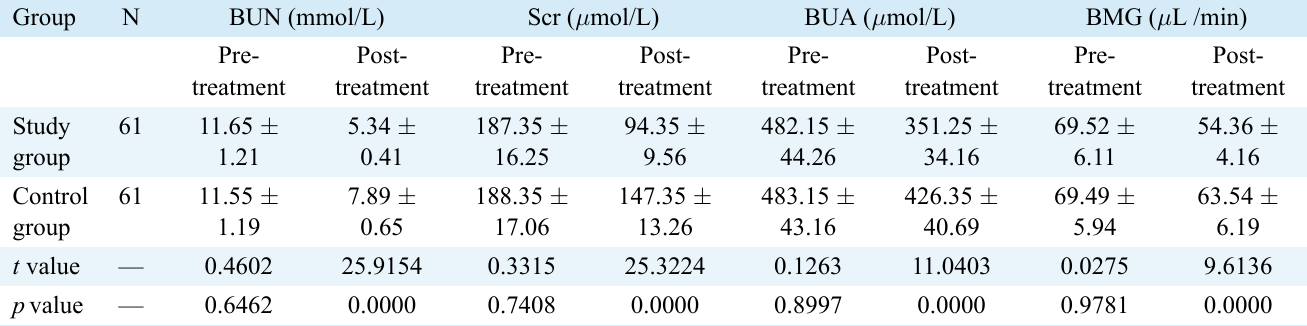
TABLE 2. Comparison of renal function indicators between study and control groups ( ¯ x ± s ).